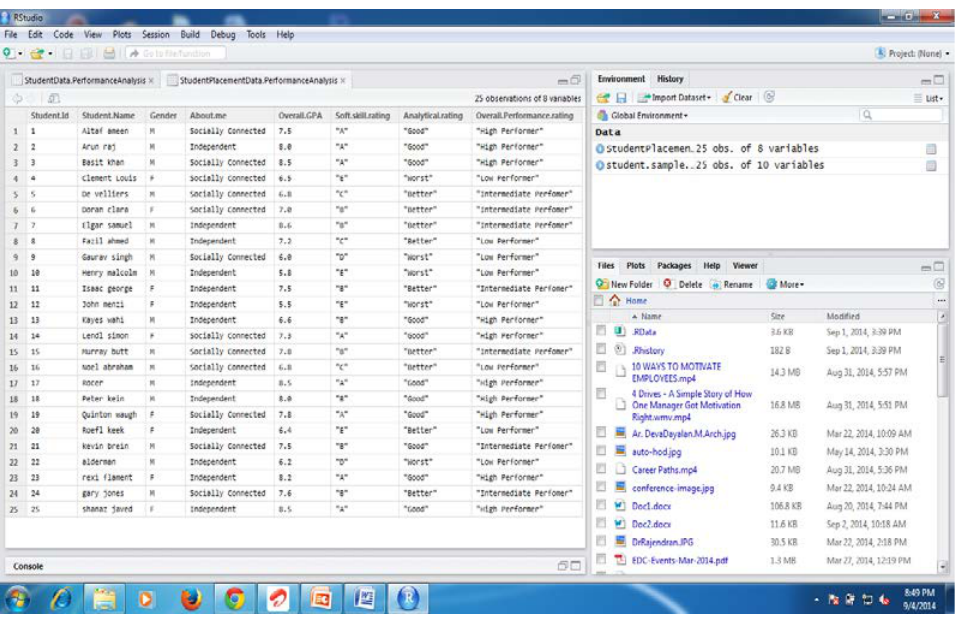
Figure 4 . Screenshot for data